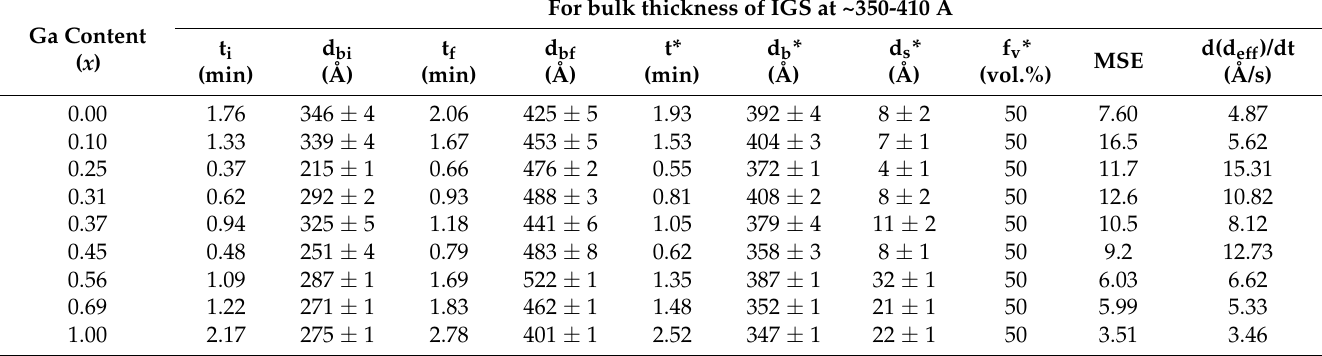
Table 6. Initial time t i , final time t f and center time t*, selected for the multi-time analyses of RTSE data in the early stages of IGS depositions with different Ga contents x shown in the first column. The best fit bulk layer thicknesses at t i , t f , and t* are given, as well as the best fit surface roughness layer thickness and fixed void volume percentage in the surface roughness layer both at t*. The results were obtained from RTSE analysis which was also used to extract the early stage ( ε 1 , ε 2 ) spectra as b-splines. The mean square errors from the best fit analyses are shown in the second-to-last column. The deposition rates, provided in the last column, are given as the time derivative of the effective thickness (volume/area) at t*. These effective deposition rates are larger than (d b * + 0.5d s *)/t* since the latter average rate does not include the time-independent interface IGS contribution of d i f IGS and in addition, variations in rate can occur in the early stages of the